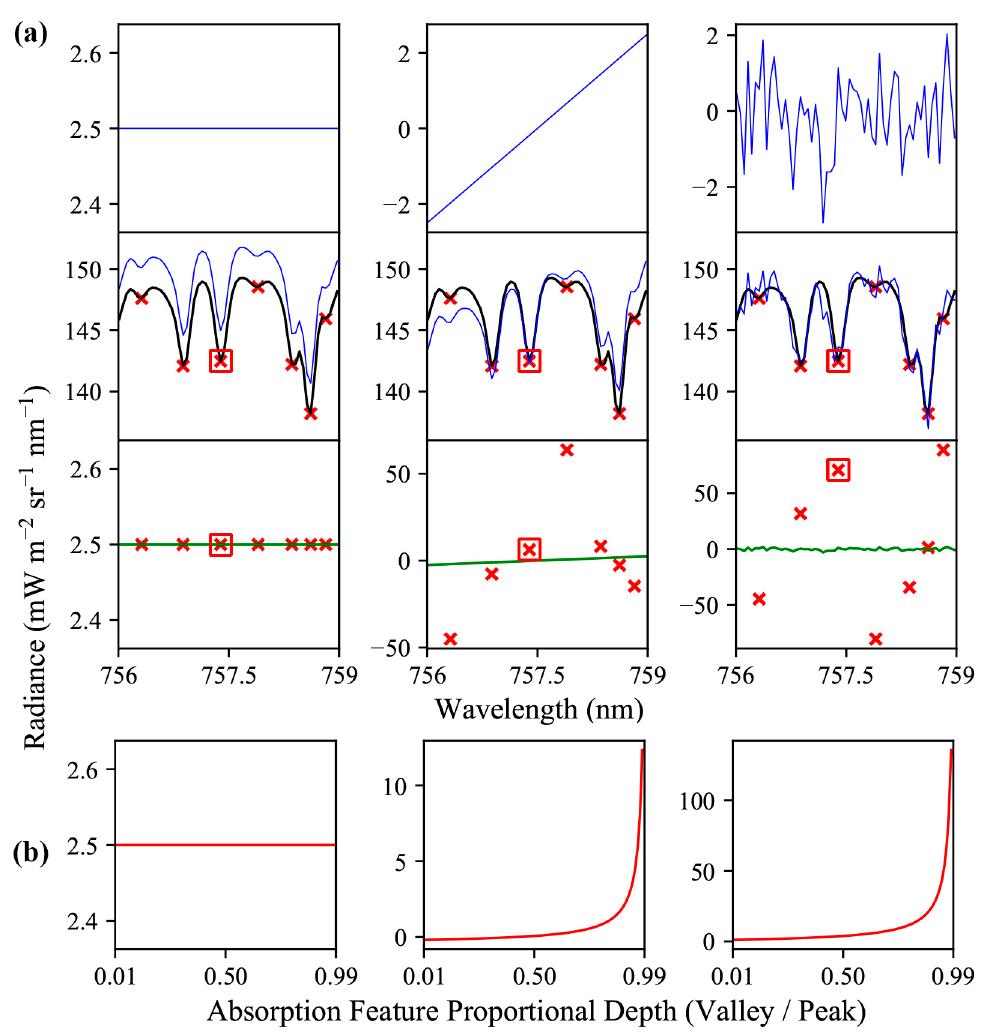
Figure 3. ( a ) Different types of influences (top row, blue line) that can confound SIF retrievals: uniform (left column), and non-uniform sloped (center column) and random (right column). Each of these influences is applied (middle row) to a sample of simulated FIREFLY spectra (black line), resulting in an adjusted spectrum (blue line). Valleys for indirect SIF retrieval (red x) are shown for seven absorption features. The resulting error in the SIF retrieval (bottom row) is shown for direct retrievals from every band (green line), and indirect retrievals from the absorption features (red x). ( b ) One absorption feature (identified by the red boxes in (a)) is simulated over a range of proportional depths to show the reaction of indirect SIF retrievals to uniform (left), sloped (middle), and random (right) influences.